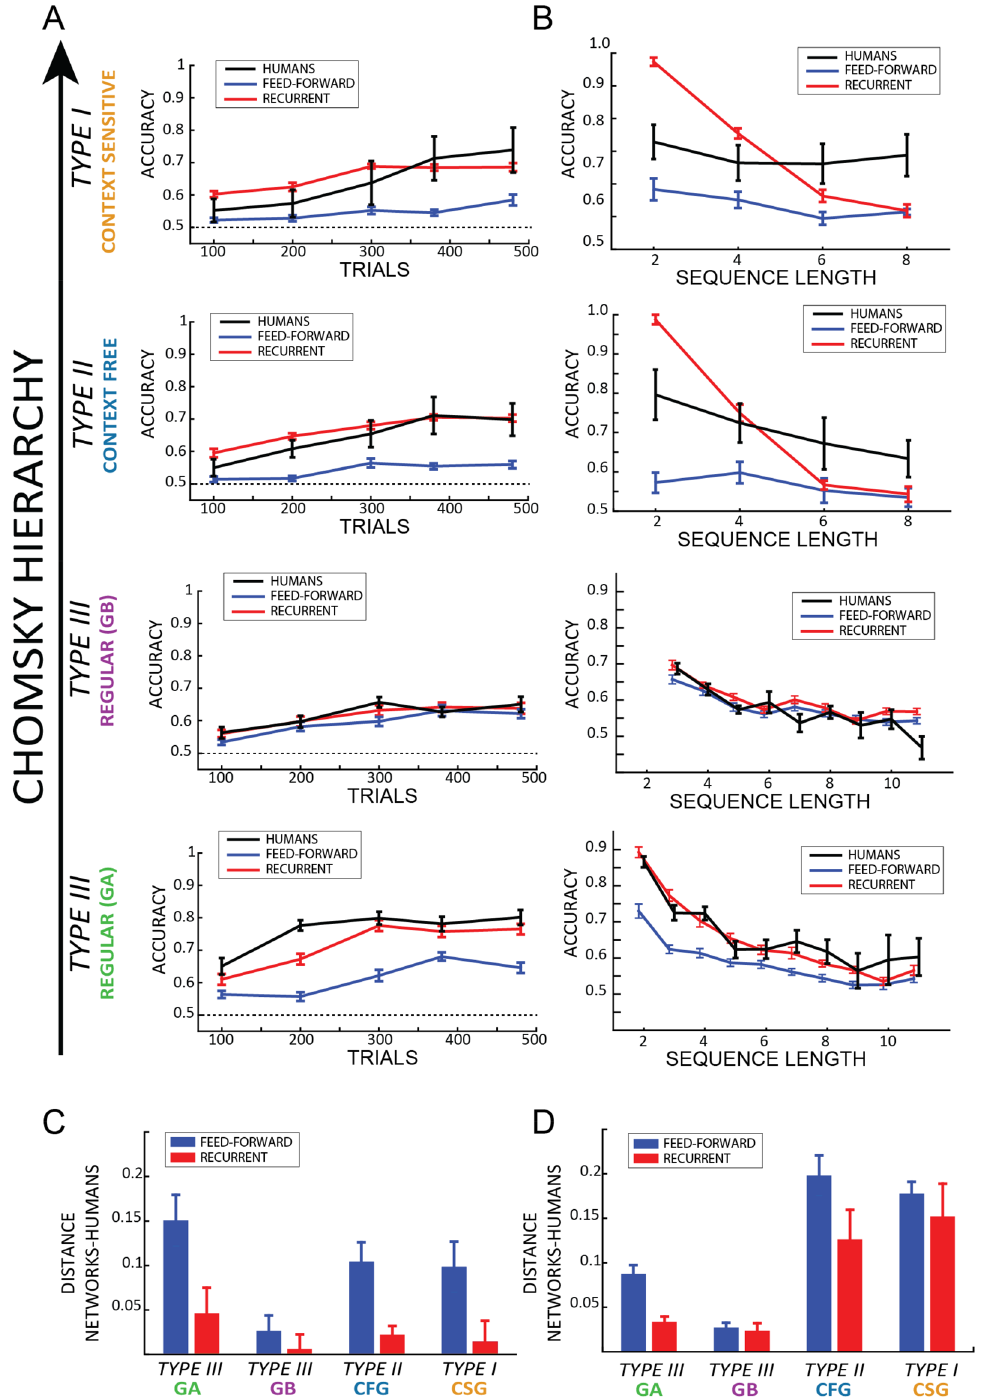
Figure 4. ( A , B ) Results over trials ( A ) and string lengths ( B ) for humans (in black) feedforward (in blue) and recurrent (in red) networks. For humans in ( A ) each bin is an average over 40 trials (20 trials before and after respectively, except the last bin which includes the last 40 trials of the experiment). Each row represents a grammar, ordered according to the Chomsky’s hierarchy. ( C , D ) The plots show the distance between humans’ performance and FF (in blue) and RR (in red). Each distance represents the area measured between the human and the network curves. Except for grammar B, RR networks are significantly closer to human performance, both as a function of training time and sequence